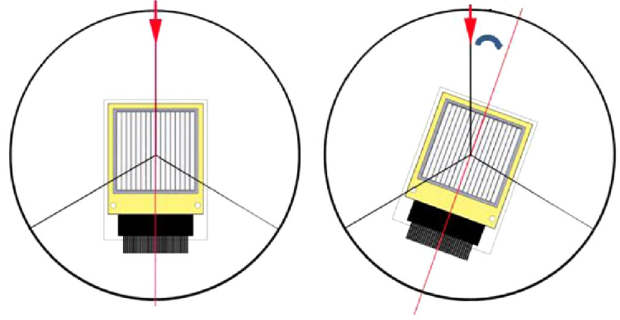
FIG. 7. Illustration of the rotation of the detector and the angle between the strips and the beam axis (indicated by the